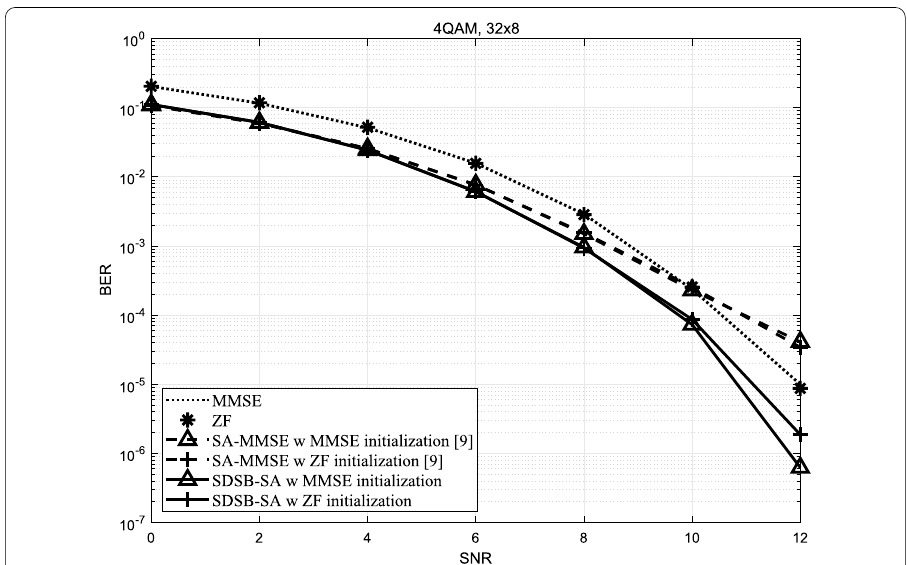
Fig. 4 Performance comparison of MMSE/ZF, MMSE/ZF MIMO system,